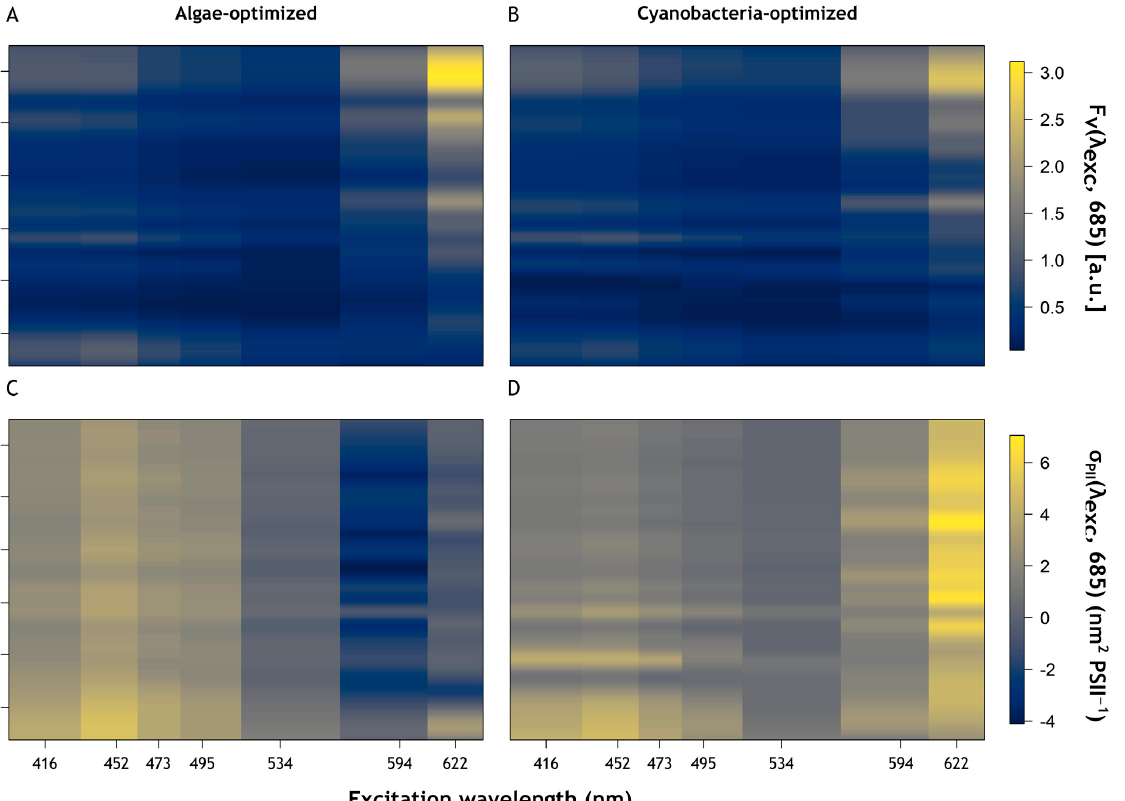
Figure 6. Photosynthetic Excitation spectrum results. ( A ) F v ( λ exc , 685) [a.u.], algae-optimised. ( B ) F v ( λ exc , 685) [a.u.], cyanobacteria-optimised. ( C ) σ PII ( λ exc , 685) (nm 2 PSII -1 ), algae-optimised. ( D ) σ PII ( λ exc , 685) (nm 2 PSII -1 ), cyanobacteria-optimised.